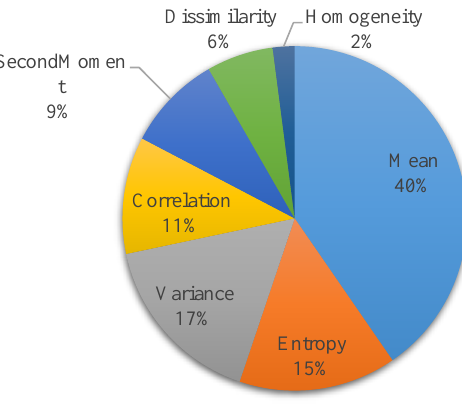
Figure 9. The proportion of 28 texture features in the first 31 features.